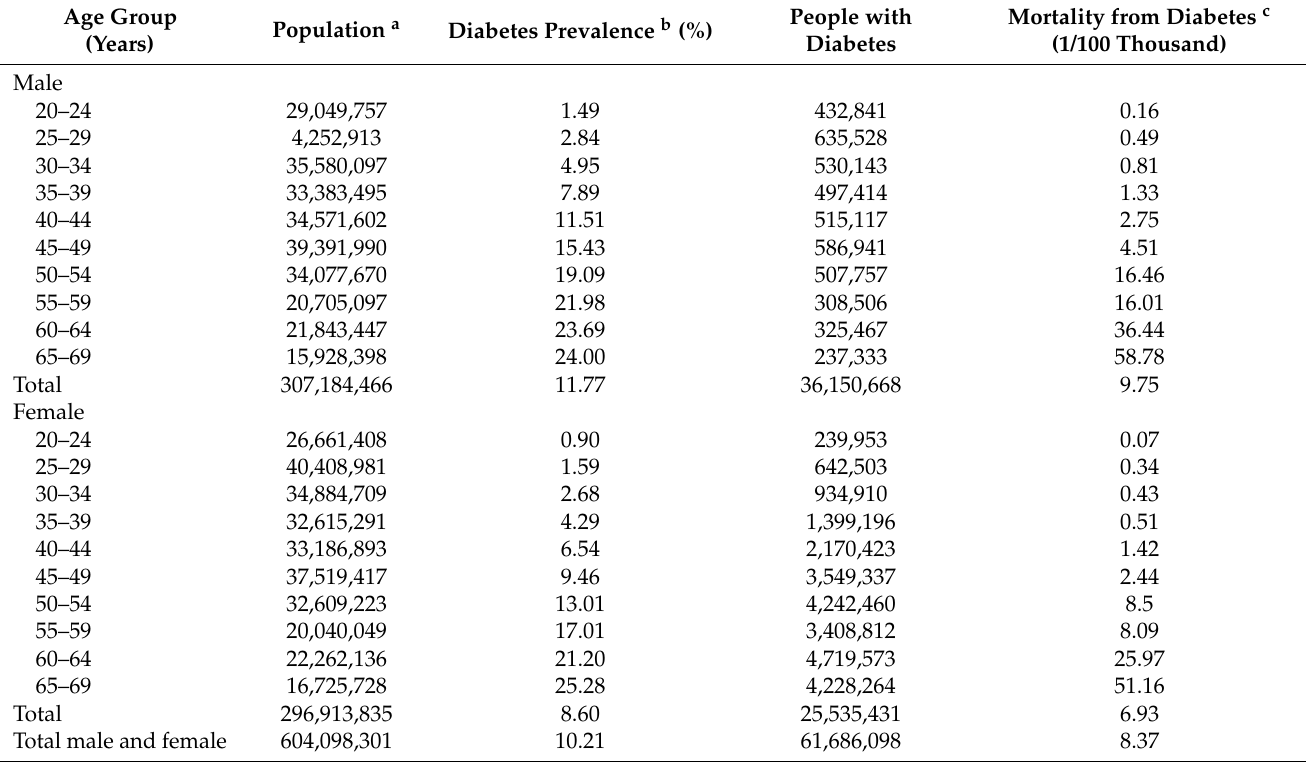
Table 1. Population, prevalence, and mortality from diabetes in urban China in 2017.